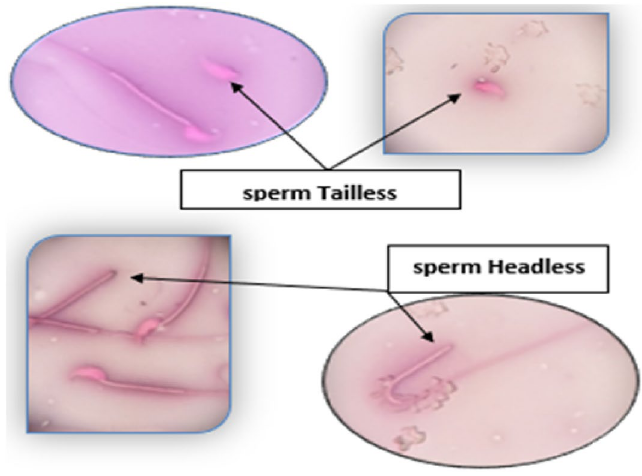
Figure 14. Sperm without tail & sperm without Head. Slide stained with Nigrosine and Eosin stain (100×).